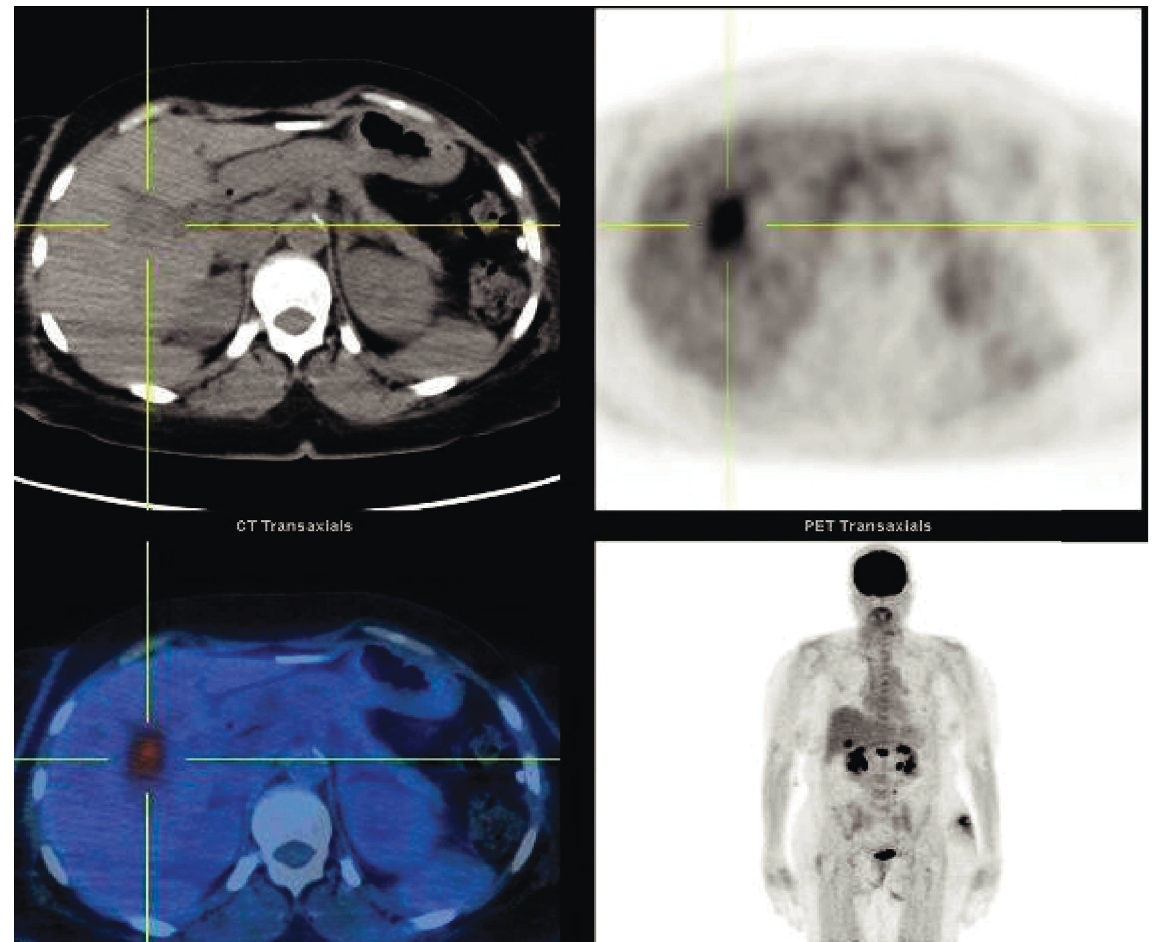
Figure 8: Follow-up PETafter the 3 rd cycle of CHOEP. Interval resolution of supraclavicular, hilar, and axillary uptake. Increased uptake in the right hepatic lobe (SUV 5.8). New uptake in L1 (SUV 8.8). PET: positron emission tomography; CHOEP: cyclophosphamide, Adriamycin, vincristine, etoposide, and